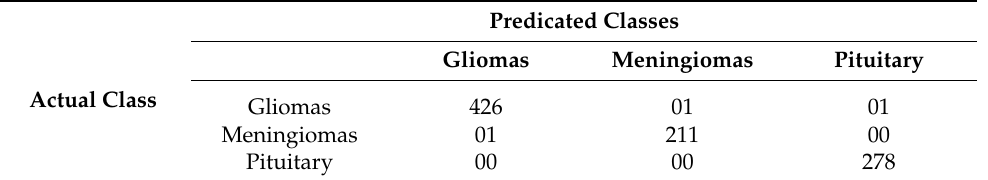
Table 6. Confusion matrix of proposed hybrid